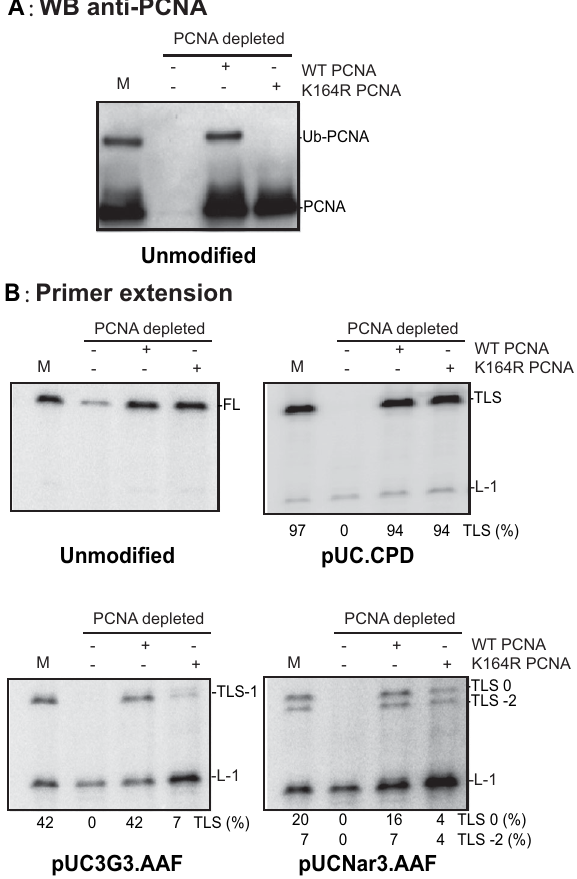
Figure 4. Analysis of Ub-PCNA dependence of G-AAF bypass in MRC5 cell-free extracts. Mock depleted (M) or PCNA depleted MRC5 cell extracts (20 mg) were incubated 30 min at 37 u C in the presence of 10 fmoles of unmodified or modified substrates in a final volume of 6.25 ml, as indicated. Recombinant wild-type (WT) or mutated K164R PCNA (60 ng) was added to the reactions, as indicated. Aliquotes of the samples were analysed either by Western blot with an anti-PCNA antibody (panel A) or by 8% denaturing polyacrylamide gel electro- phoresis (panel B). L-1 is a product generated if synthesis is blocked one nucleotide before the lesion. TLS0 and TLS-1 or –2 are products from TLS via non-slipped and slipped intermediates, respectively. FL are Full Length products.